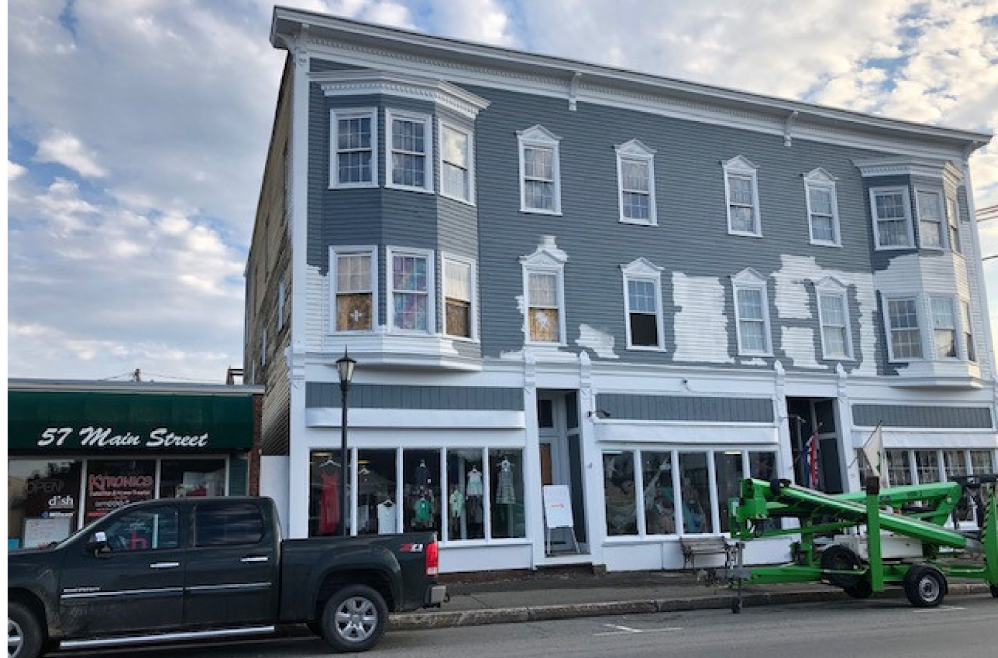
Figure 14. From transect across Central Maine: Stage 5–Renaissance. Marijuana shop in Madison, Maine, getting a facelift (September 2019). (Photo courtesy of Betty